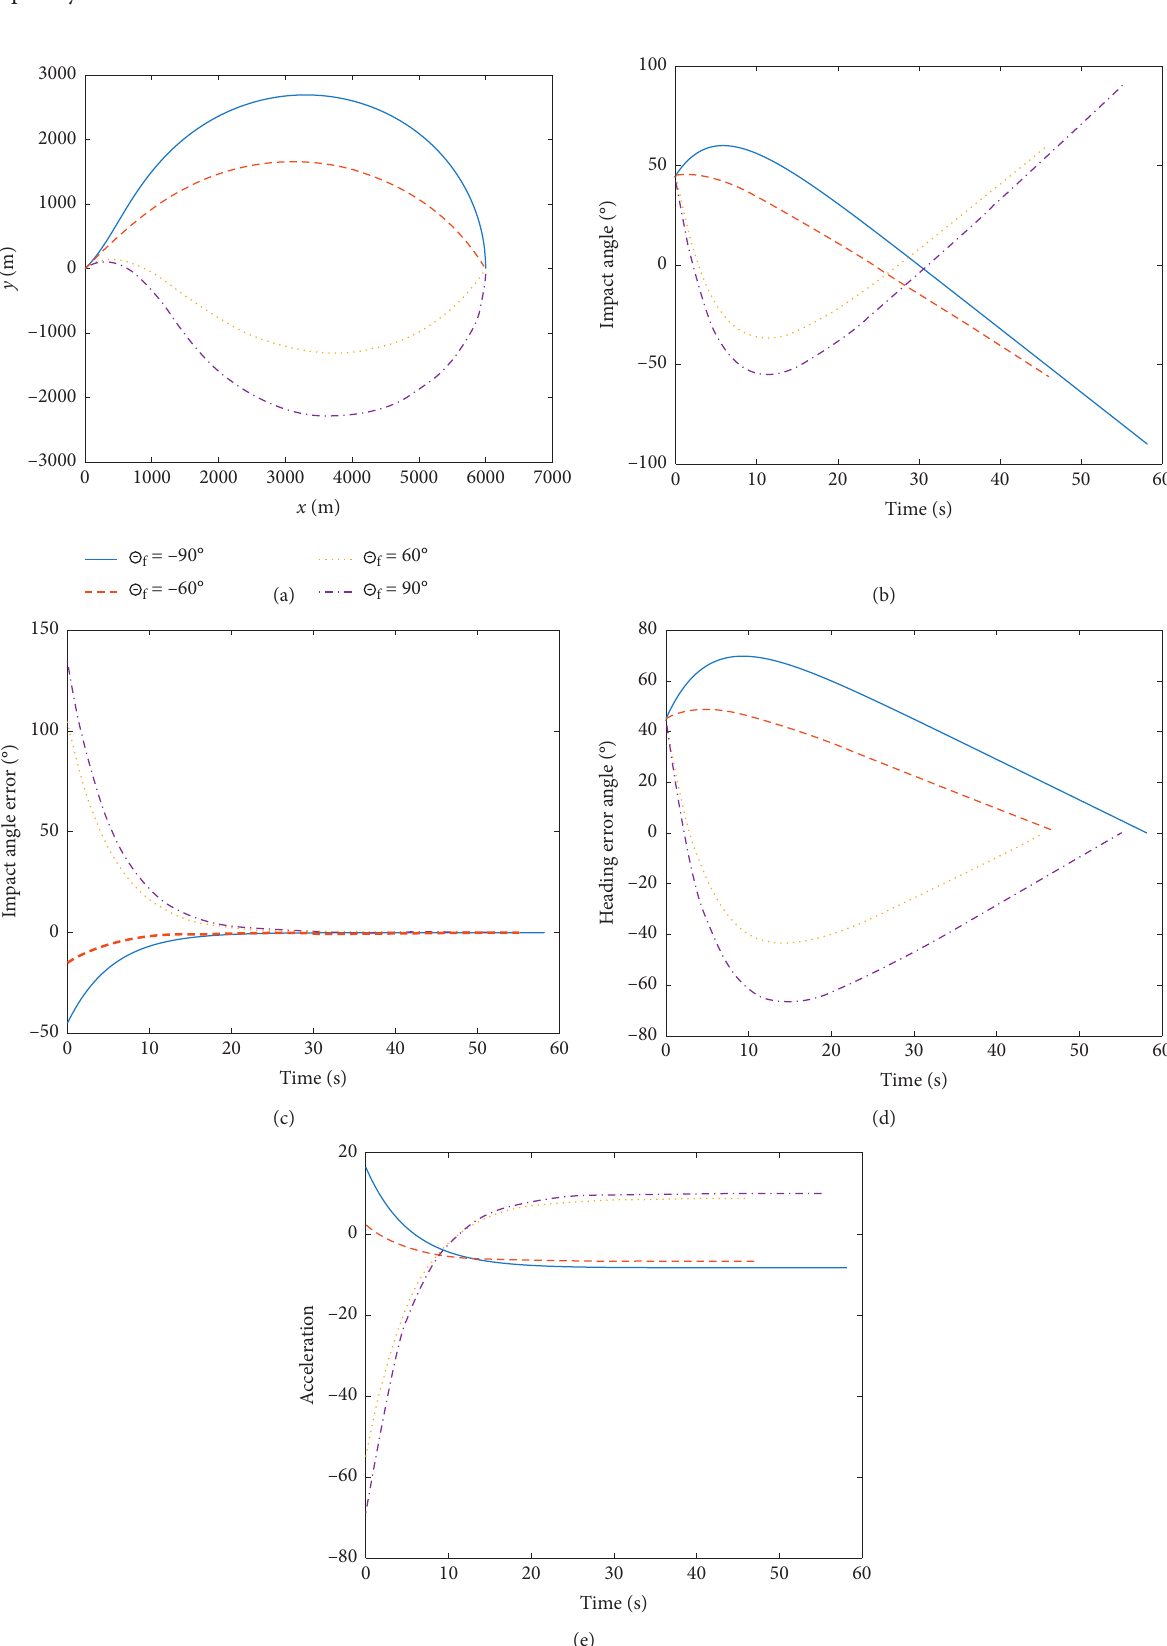
Figure 5: Various impact angles under the same control parameters. (a) Trajectories. (b) Impact angle. (c) Impact angle error. (d) Heading error angle. (e)